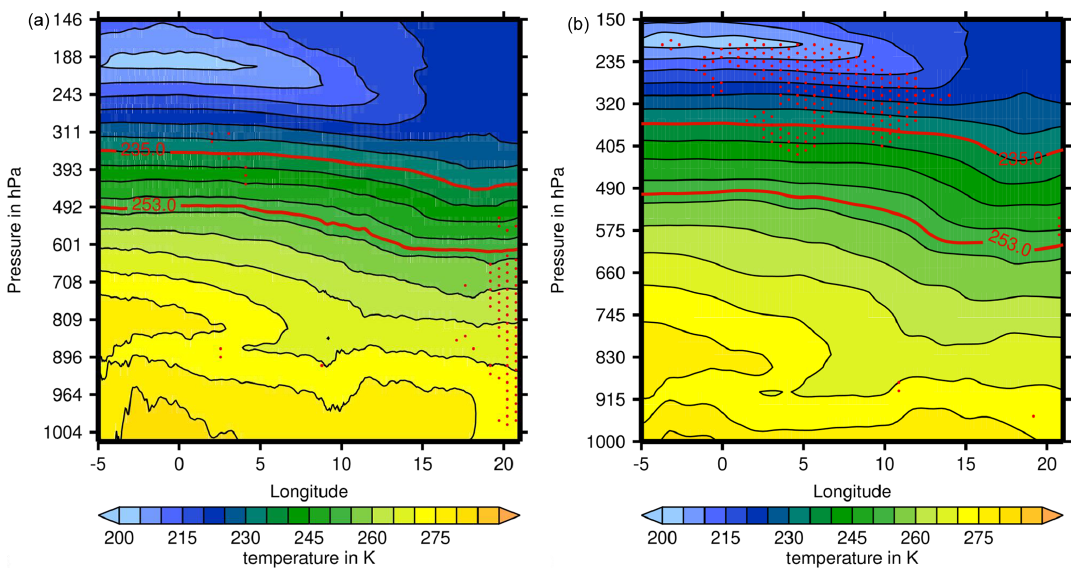
Figure 5. (a) Temperature field from ICON-EU. (b) Temperature field from ERA5. The two red lines mark 253 and 235K for orientation. Below 253K, the relative humidity in ERA5 is defined with respect to ice; 235K is the threshold for spontaneous freezing of water droplets; that is, below that temperature, condensed water is ice. Ice supersaturation is true at T < 235K, while above that threshold it might be simply the vapour phase in a supercooled liquid cloud. Stippling indicates ice supersaturation, which at temperatures above 235K implies the presence of a mixed-phase or supercooled-water